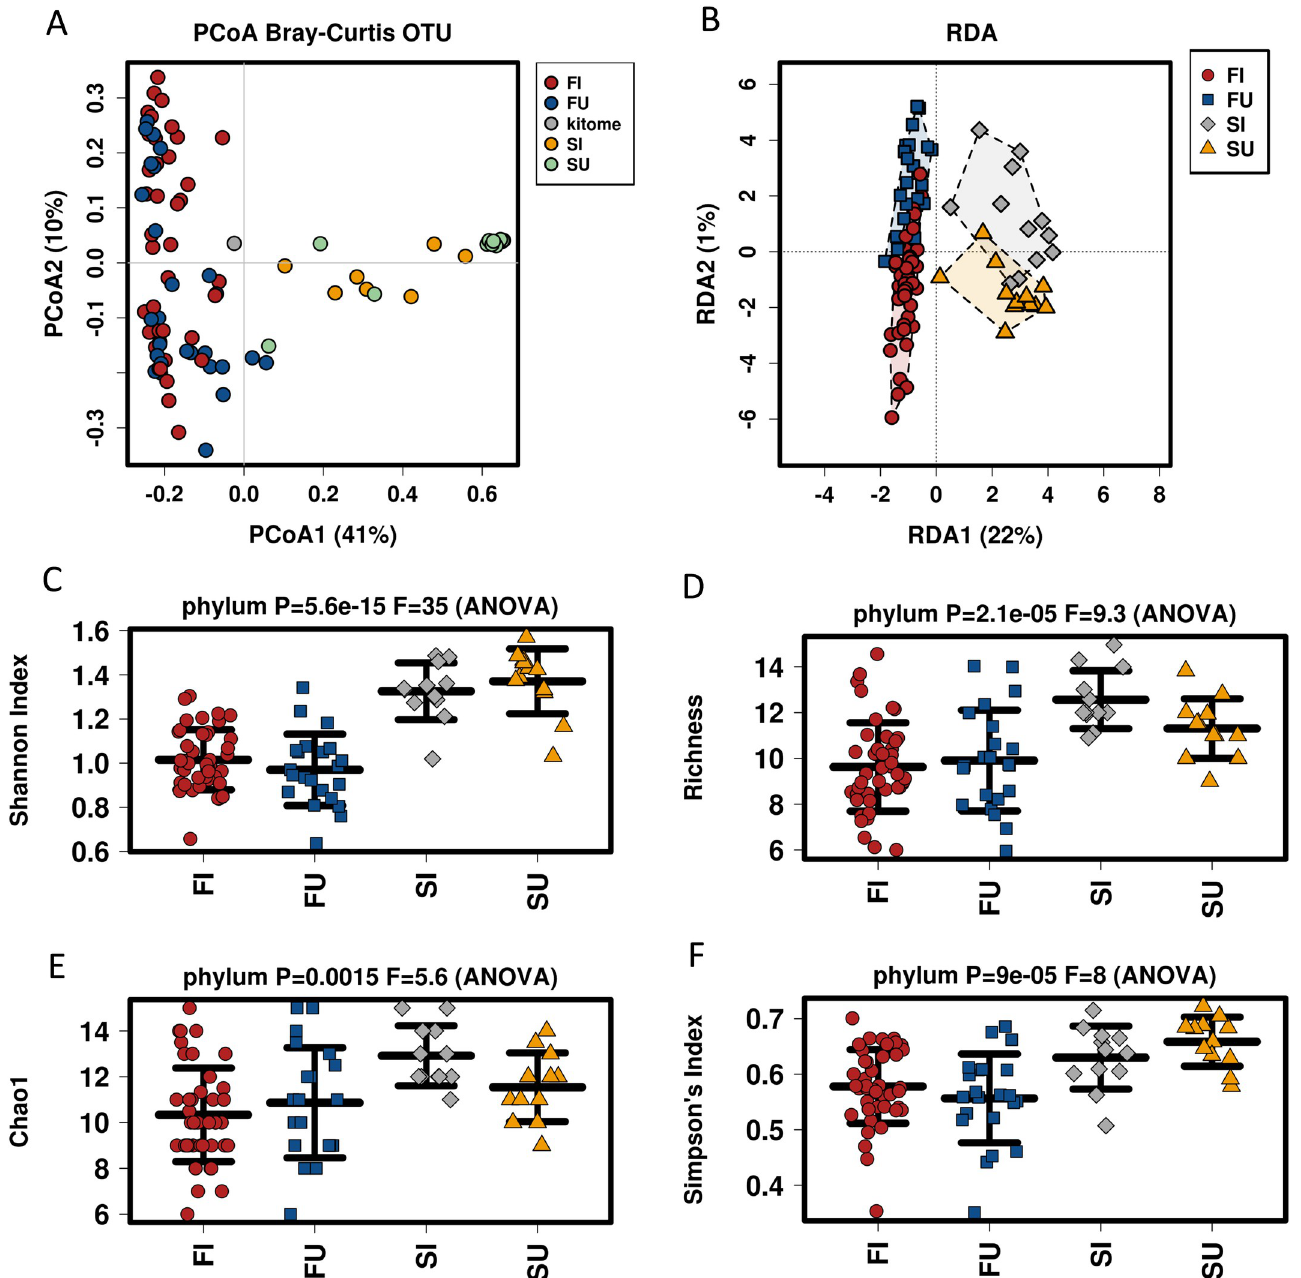
Fig 3. Multivariate and alpha diversity analysis of faecal and saliva sample by infection status, demonstrates differences in the microbiota of these two biological samples. A. Unsupervised Principal Coordinates Analysis (PCoA) methods were used at the OTU level B. Redundancy Analysis (RDA- OTU level) demonstrating that differences between faecal and saliva samples were statistically significant ( p-value = 0.001). C-F. All four diversity analysis methods indicated statistical differences between the sample sources at the phylum level. FU = Faecal Uninfected (blue), FI = Faecal Infected (red), SU = Saliva Uninfected (yellow), SI = Saliva Infected